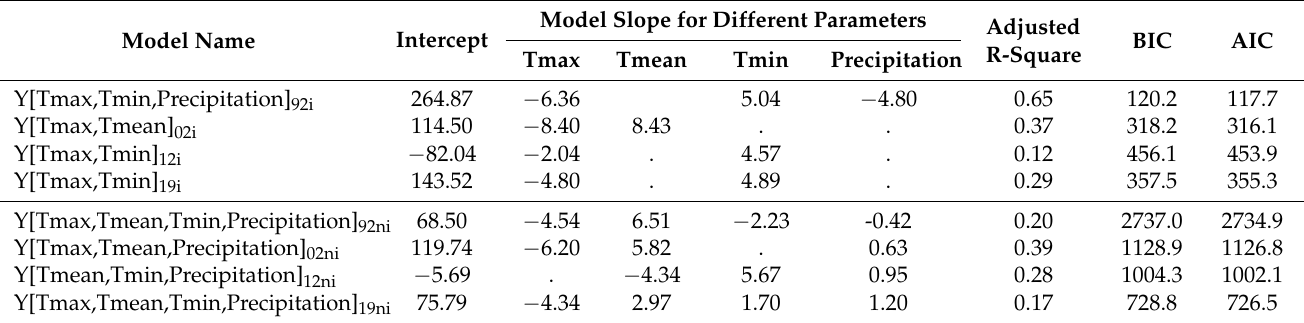
Table 1. The results of the best temporal linear and multilinear models for each 10-year period from time series of 1980–2019 for the irrigated and non-irrigated counties of Mississippi.